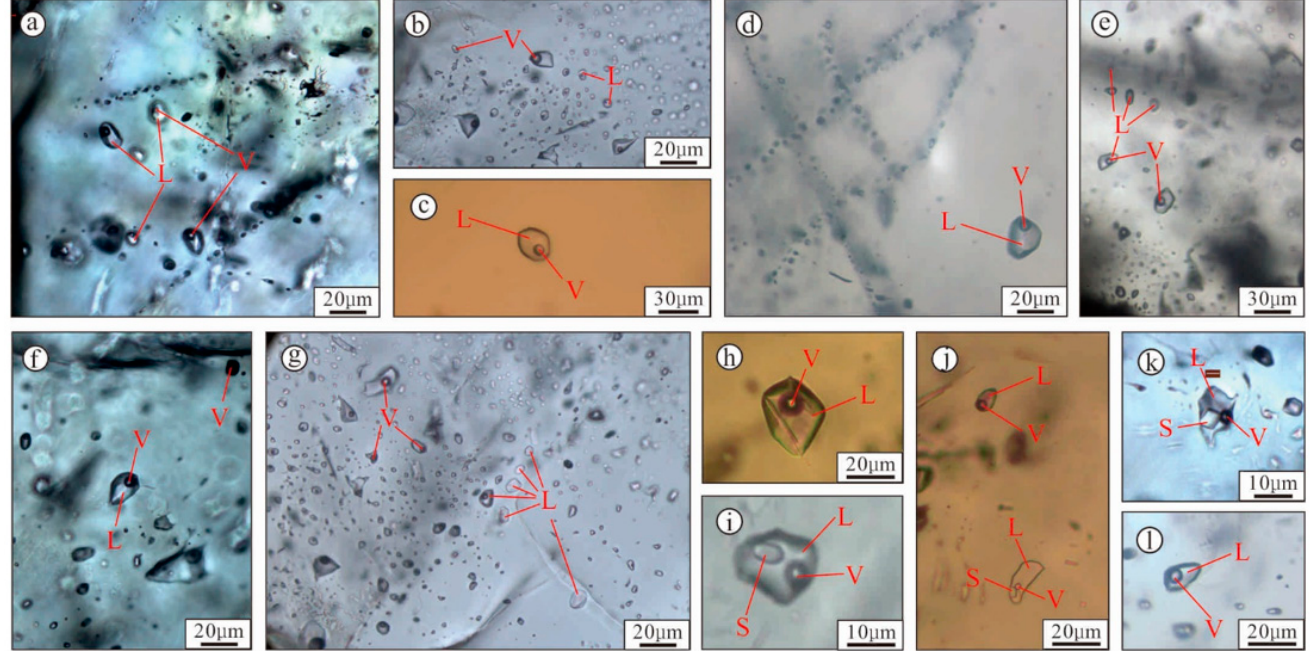
Figure 7. Photomicrographs of fluid inclusions in the celestine deposit in the study area showing representative primary, two-phase (liquid + vapor) fluid inclusions, and three-phase (liquid + vapor + solid) fluid inclusions in the celestine. ( a ) Primary two-phase fluid inclusions and secondary gaseous inclusions, with the latter showing directional orientation. ( b ) Fluid inclusions group. ( c ) Isolated fluid inclusions. ( d ) Isolated primary fluid inclusions and bead-like secondary inclusions. ( e ) and ( f ) are primary two-phase fluid inclusions and pure liquid inclusions. ( g ) Primary two-phase fluid inclusions and pure vapor inclusions. ( h ) Suborbicular fluid inclusion. ( i ) and ( j ) are primary three-phase fluid inclusion, showing that the daughter minerals are rectangular. ( k ) Irregular three-phase fluid inclusion, showing that the daughter mineral is square. ( l ) Oval fluid inclusion.